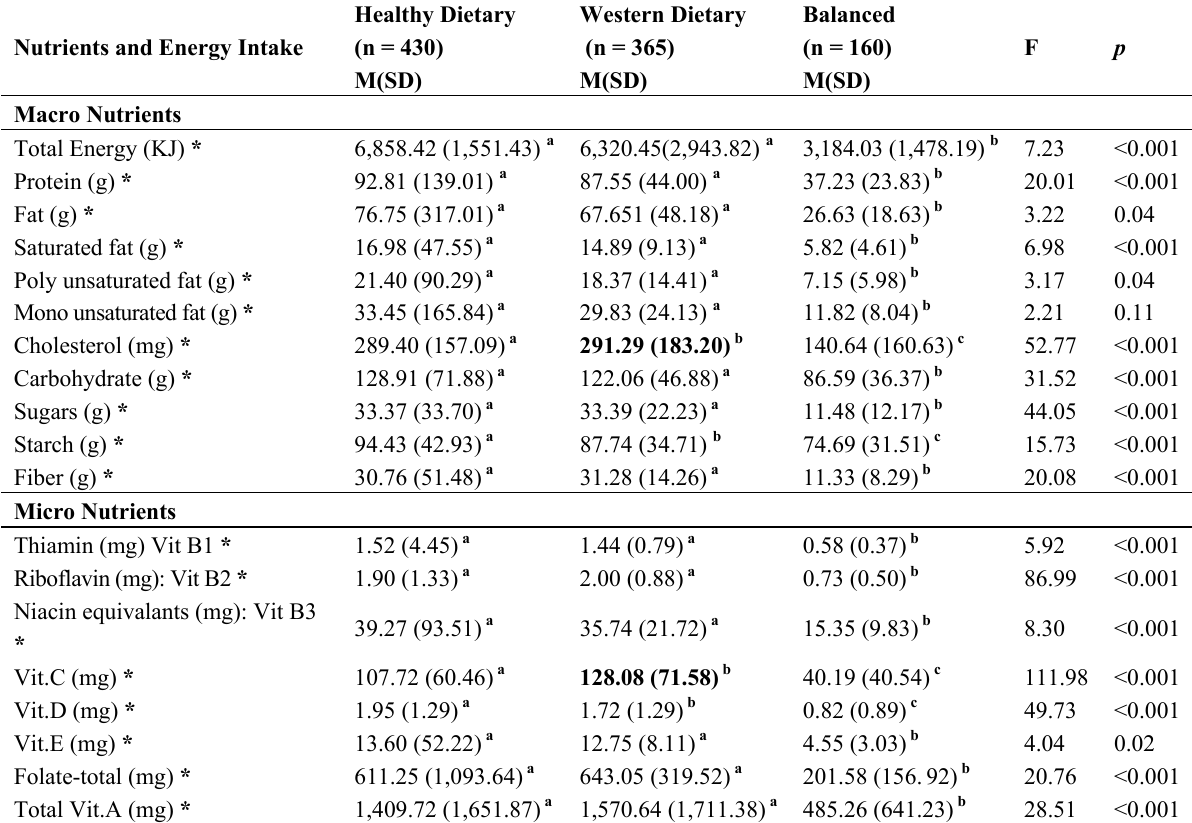
Table 4. Association between dietary patterns and